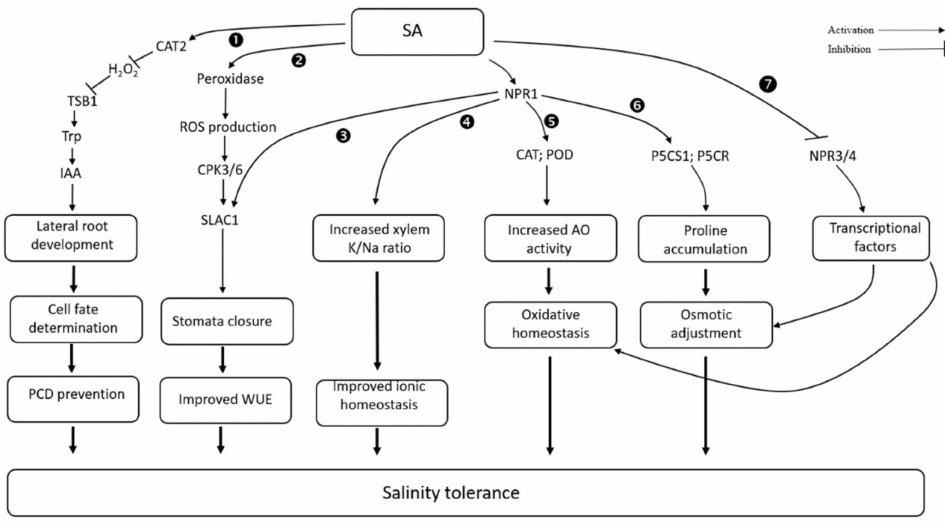
Figure 2. Effect of salicylic acid on salt stress tolerance in plants (based on (cid:182) [212], (cid:183) [213], (cid:184) [214,215], (cid:185) [52], (cid:186) [193,200], (cid:187) [52,207], and (cid:188)